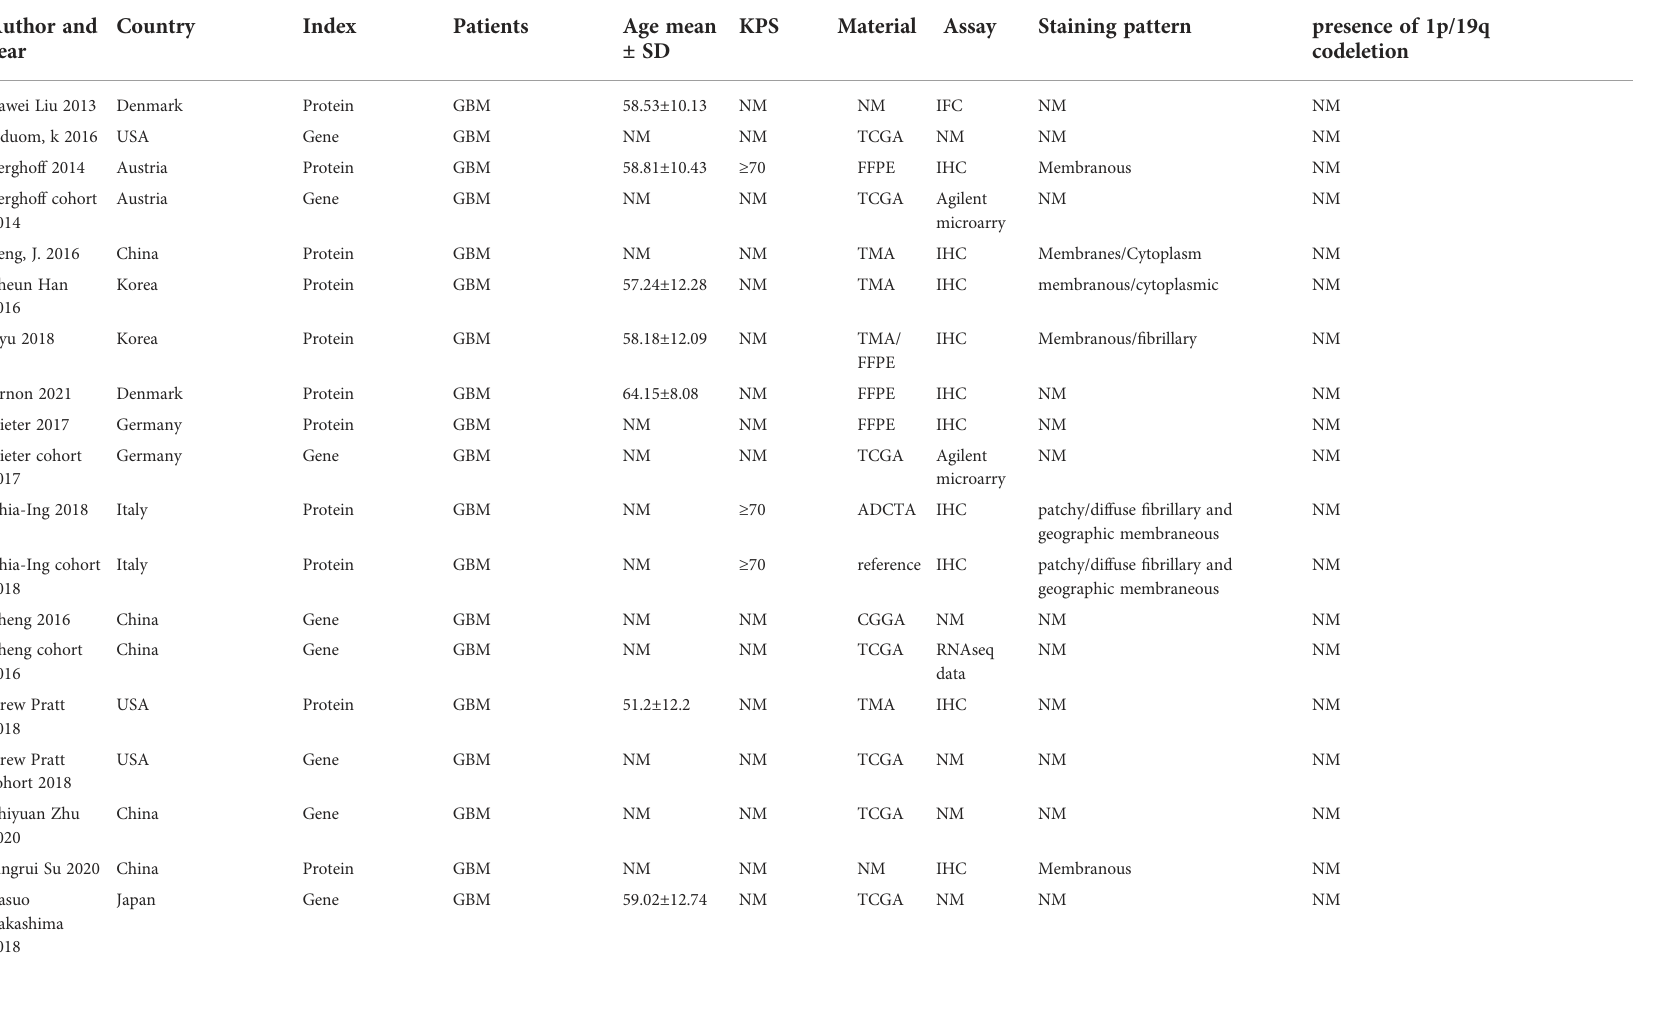
TABLE 1 Basic characteristics of the included